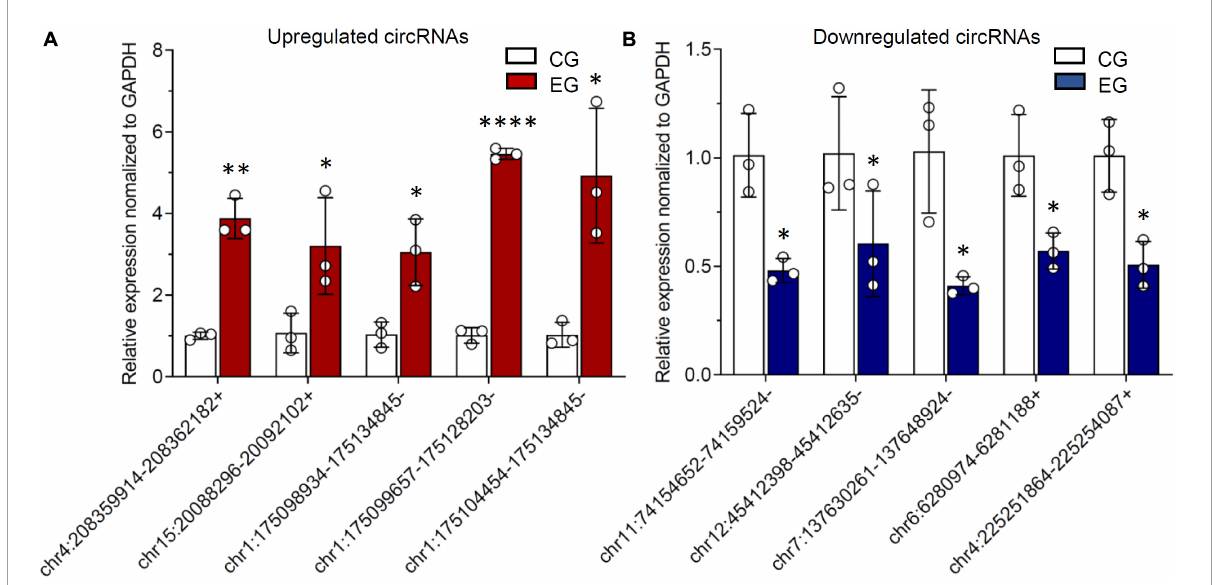
FIGURE5 Differentially expressed circular RNAs (circRNAs) from circulating exosomes are verified by reverse transcription-polymerase chain reaction (RT-PCR). (A) The relative expression levels of upregulated circRNAs, including chr4:208359914–208362182+, chr15:20088296–20092102+, chr1:175098934– 175134845–, chr1:175099657– 175128203–, and chr1:175104454–175134845–. (B) The relative expression levels of downregulated circRNAs, including chr11:74154652– 74159524–, chr12:45412398– 45412635–, chr7:137630261– 137648924–, chr6:6280974–6281188+, and chr4:225251864–225254087+. ∗ P < 0.05, ∗∗ P < 0.01, ∗∗∗∗ P < 0.0001.